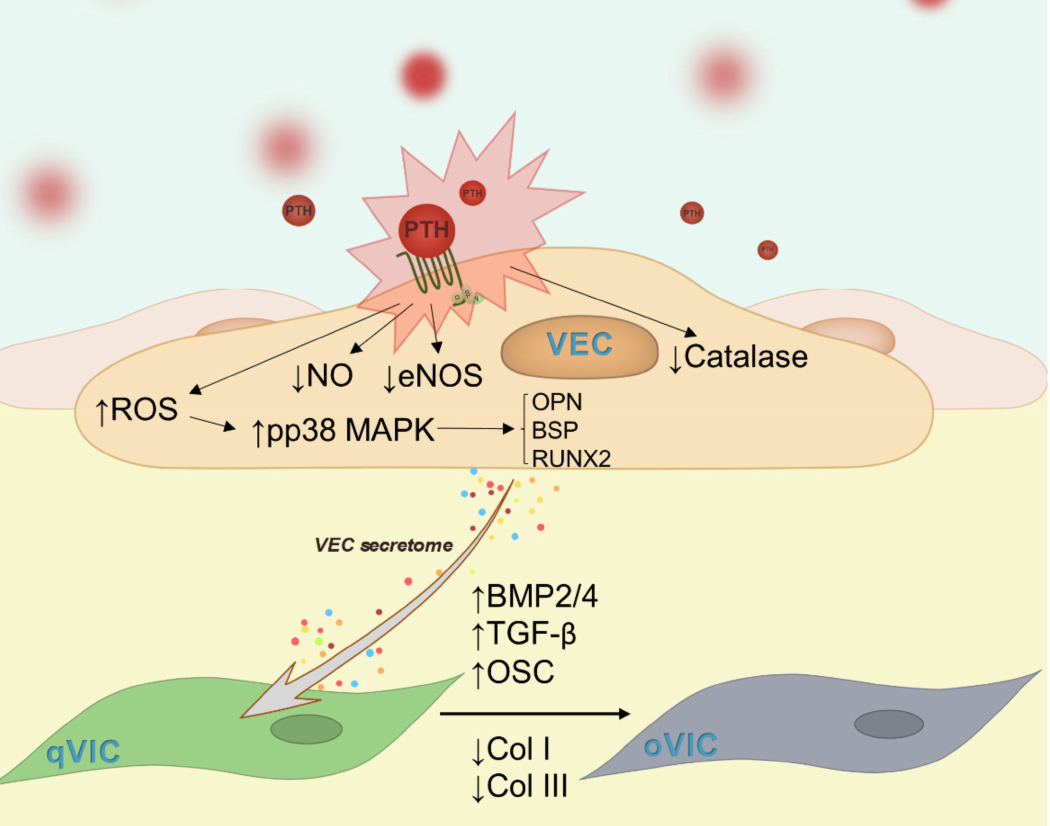
Figure 9. Summary figure. Exposure of VEC to PTH induces dysfunction to VEC, as revealed by decreased levels of NO, eNOS and catalase activity, increased ROS, activation of p38MAPK and over- expression of osteogenic molecules: osteopontin, BSP and Runx2. Factors released by dysfunctional VEC further stimulate VIC to differentiate into a pro-osteogenic phenotype, with increased expression of BMP-2/4, TGF- β 1 and osteocalcin and decreased collagen I and III, modifications associated with the calcification